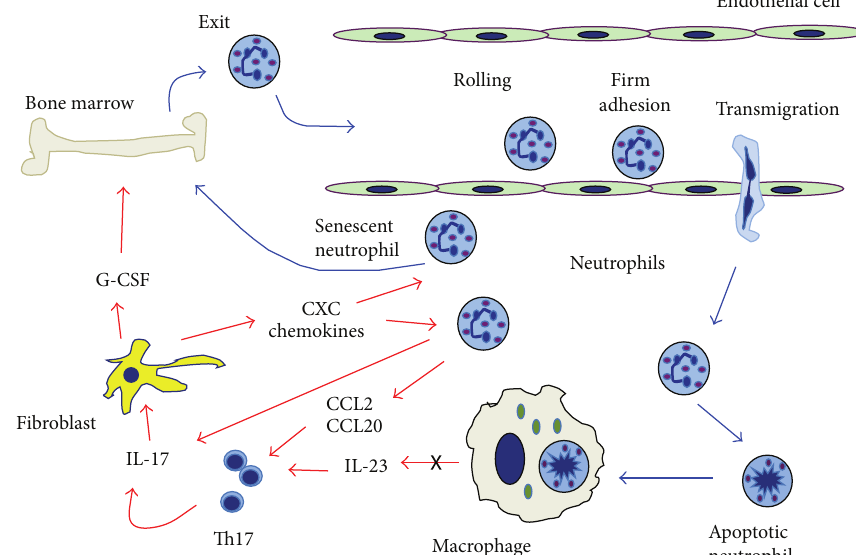
Figure 2: Neutrophil trafficking . A neutrophil rheostat (neutrostat) that maintains steady-state neutrophil levels involves the axis interleukin- (IL-) 23/IL-17/granulocyte colony-stimulating factor (G-CSF). Granulopoiesis takes place in the bone marrow where proliferation of granulocytic precursors is induced by G-CSF. The exit of mature neutrophils from the bone marrow into the blood circulation is also regulated by G-CSF. Circulating neutrophils roll on endothelial cells at sites of infection of inflammation. Upon firm adhesion mediated by integrins, neutrophils can transmigrate into the tissues. There, neutrophils perform their antimicrobial functions and then die by apoptosis. Apoptotic neutrophils are phagocytosed by macrophages. This initiates an anti-inflammatory signal that reduces IL-23 production from macrophages (black cross). IL-23 can activate Th17 lymphocytes to produce IL-17, which promotes granulopoiesis and neutrophil release by upregulation of G-CSF in fibroblasts. An interesting positive loop for neutrophil recruitment is found at chronic inflammation sites, where neutrophils can attract Th17 cells via CCL2 and CCL20 chemokines. In turn, Th17 cells recruit more neutrophils via CXC chemokines by inducing neutrophils toproduceIL-17.SenescentneutrophilsreturntothebonemarrowforclearanceaftertheyincreaseexpressionofCXCR4.Redarrowsrepresent release of cytokines and chemokines from cells, and effect of these mediators on cells. Blue arrows represent movement of